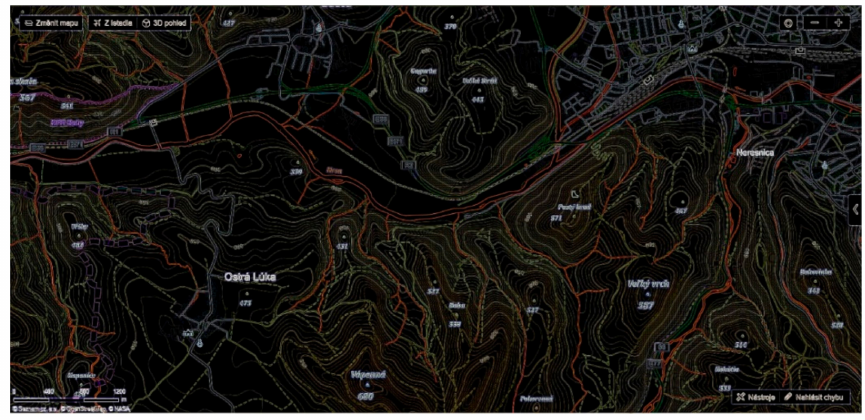
Figure 3. Edge detection image of one of the maps from the Ref-Set.